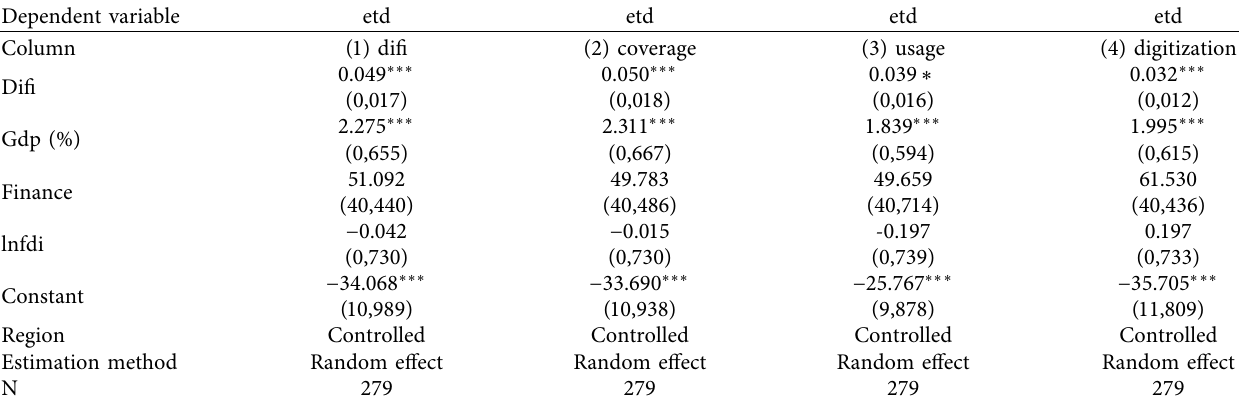
Table 3: Impact of digital financial inclusion on capital’s diversion from the fictitious to the substantial